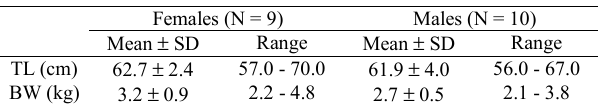
Table 1. Means, standard deviation and range of the total length (TL), body weight (BW) and animals number (N) of Lophiosilurus alexandri that responded to induced spawning.